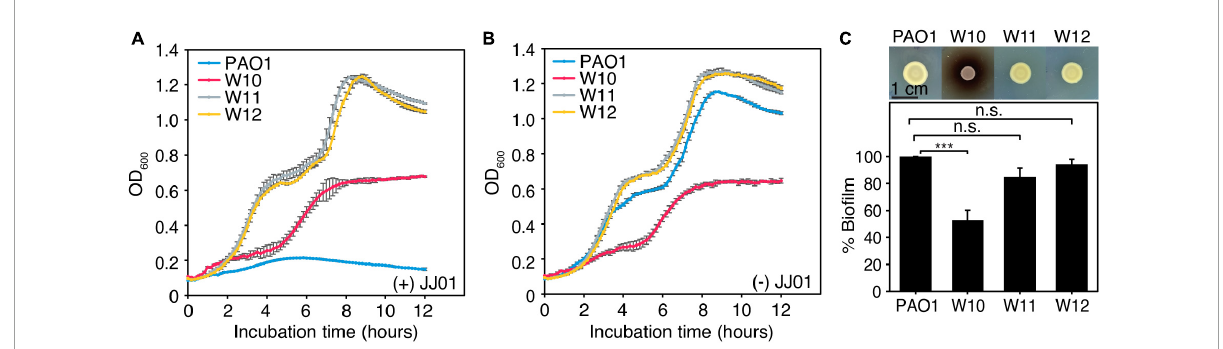
FIGURE5 (A,B) Growth curve of wild-type PAO1 and representatives of phage-resistant isolates (W10, W11, and W12) (A) in the presence of phage JJ01 at MOI 100 and (B) in the absence of phage JJ01. (C) Colony morphology of JJ01-resistant P. aeruginosa isolates compared to wild-type PAO1 (upper panel). Scale bar equals 1 cm. The biofilm production assay shows the amount of biofilm production in JJ01-resistant P. aeruginosa isolates (W10, W11, and W12) compared to wild-type PAO1 (lower panel). Asterisks represent significant differences in data ( p-value ≤ 0.001) according to one-way ANOVA followed by Tukey’s HSD post hoc tests. n.s. represents statistical non-significance of data.